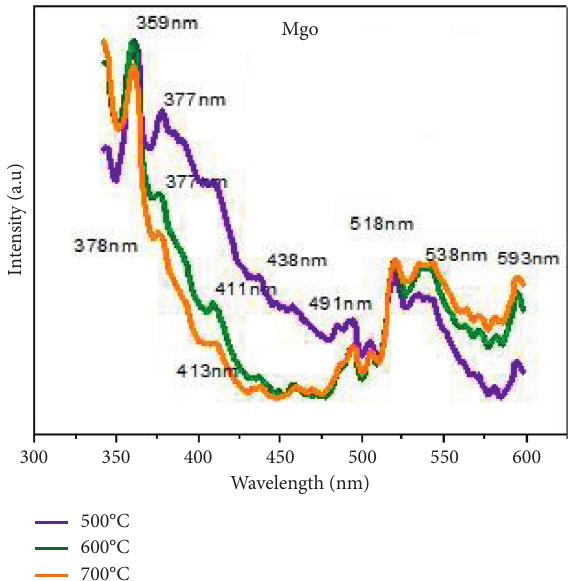
Figure 12: Photoluminescence emission spectra of MgO nanoparticles